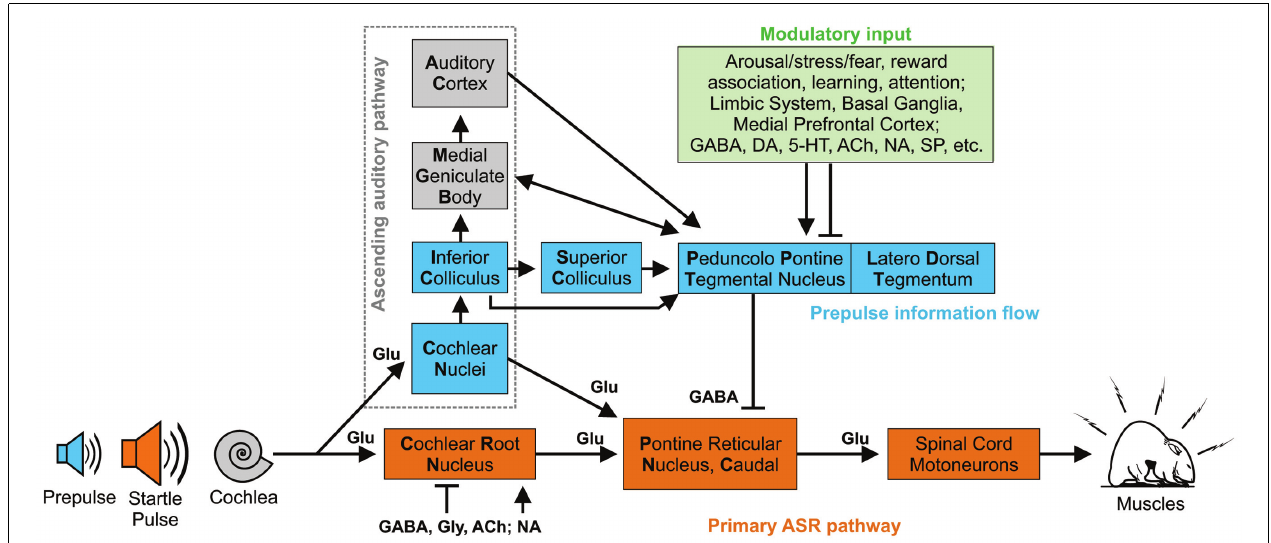
FIGURE 1 | Hypothetical simplified primary and modulatory neural circuitry underlying acoustic startle response and prepulse inhibition with presumed or confirmed neurotransmitters. In the primary ASR pathway (orange), the startle pulse sound information is transmitted via the auditory nerve to cochlear root neurons (CRN) in rodents which give short-latency input to the PnC (Pontine Reticular Nucleus, Caudal). These neurons project directly to cranial and spinal cord motoneurons to produce the motor response. Multiple pathways have been identified for sensorimotor gating modulating ASR. The acoustic prepulse is processed through the ascending auditory pathway (gray dotted frame) via the cochlear nucleus (CN) and the inferior colliculus. From there the prepulse information is transmitted directly or indirectly to the pedunculopontine tegmental nucleus (PPT) and neighboring region laterodorsal tegmental nucleus. Projections from the PPT to the PnC mediate PPI as a form of feed-forward inhibition. The PPT receives modulatory input (green pathway) from a variety of brain structures that can influence PPI e.g., linked with fear and arousal. Abbreviations: ACh, Acetyl choline; GABA, gamma aminobutyric acid; Glu, Glutamate; Gly, Glycine; DA, Dopamine; 5-HT, Serotonine; NA, Noradrenaline, SP, Substance P. Based on data and information from Lauer et al. (2017), Fulcher et al. (2020), and Gómez-Nieto et al.